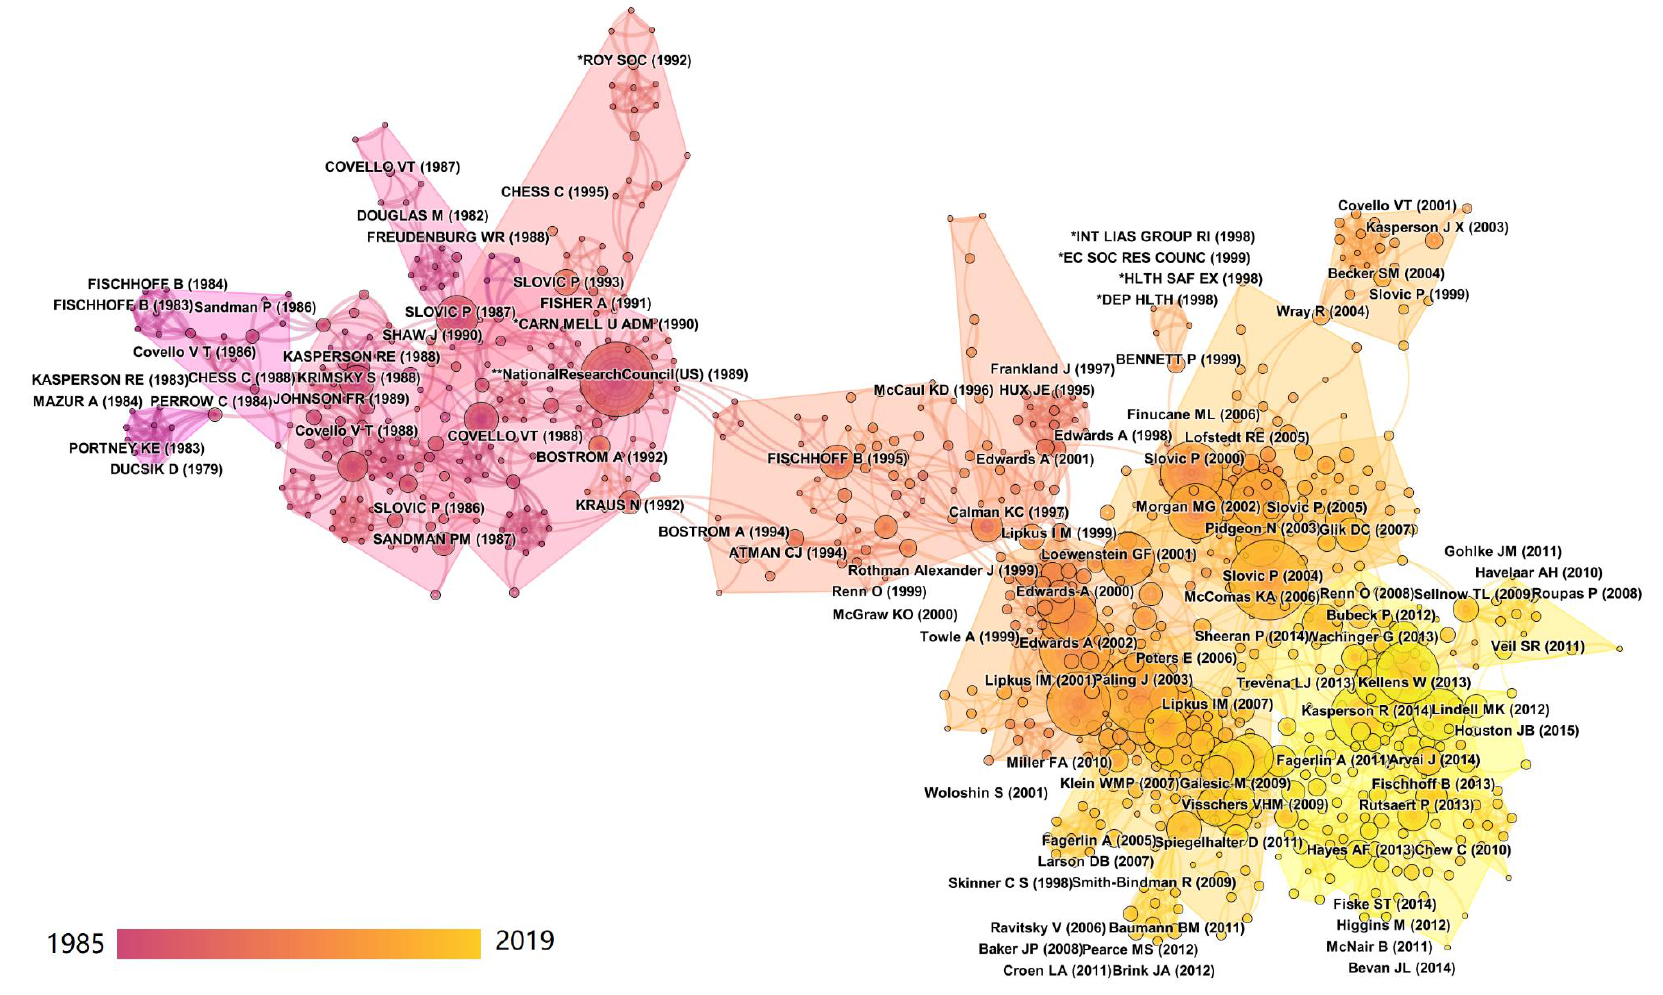
Figure 10. Top five highly cited references in each co-citation network cluster.